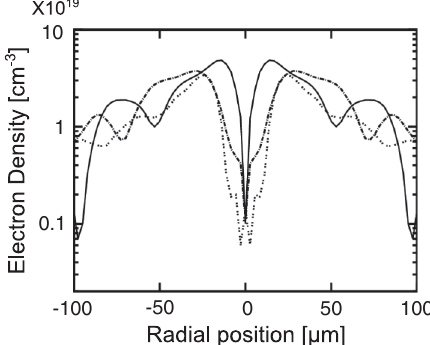
FIG. 13. Transverse density profiles at different pulse dura- tions. Solid line: 0.3 ps [Fig. 6(c)], dotted line: 1.8 ps [Fig. 7(c)], dashed line: 6 ps [Fig. 8(c)].